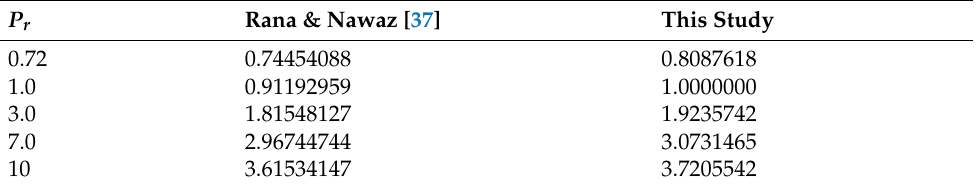
Table 3. Comparing − θ (cid:48) ( 0 ) with alteration in Prandtl number, and taking φ = 0, Υ = 0, Λ ε =